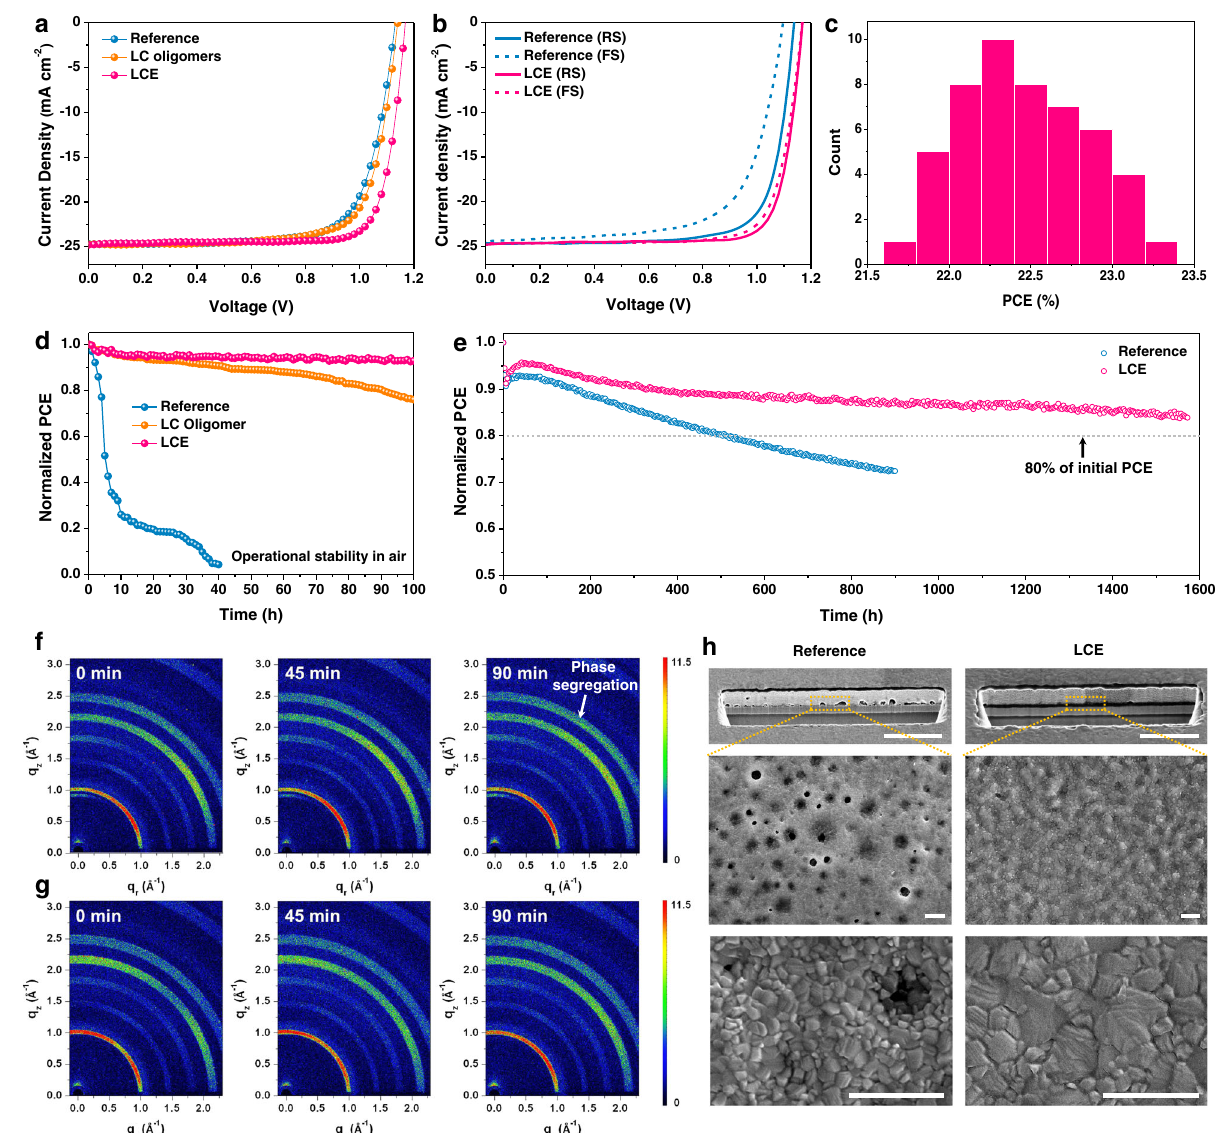
Fig.3|PhotovoltaicperformanceandoperationalstabilityofPSCs.a J – V curves of the champion PSC devices based on reference, LC oligomer, and LCE. b J – V curves of PSCs measured in reverse and forward modes. c The ef fi ciency dis- tributionof50devicesbasedonLCE. d Operationalstabilityoftheunencapsulated PSC devices based on reference, LC oligomers, and LCE in ambient air (40% RH).